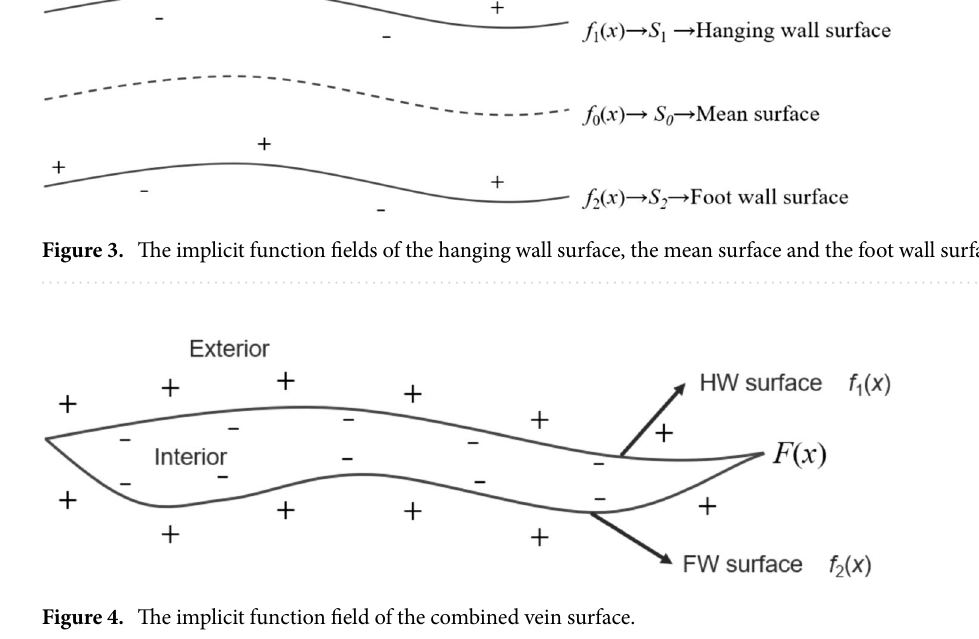
Figure 4. The implicit function field of the combined vein